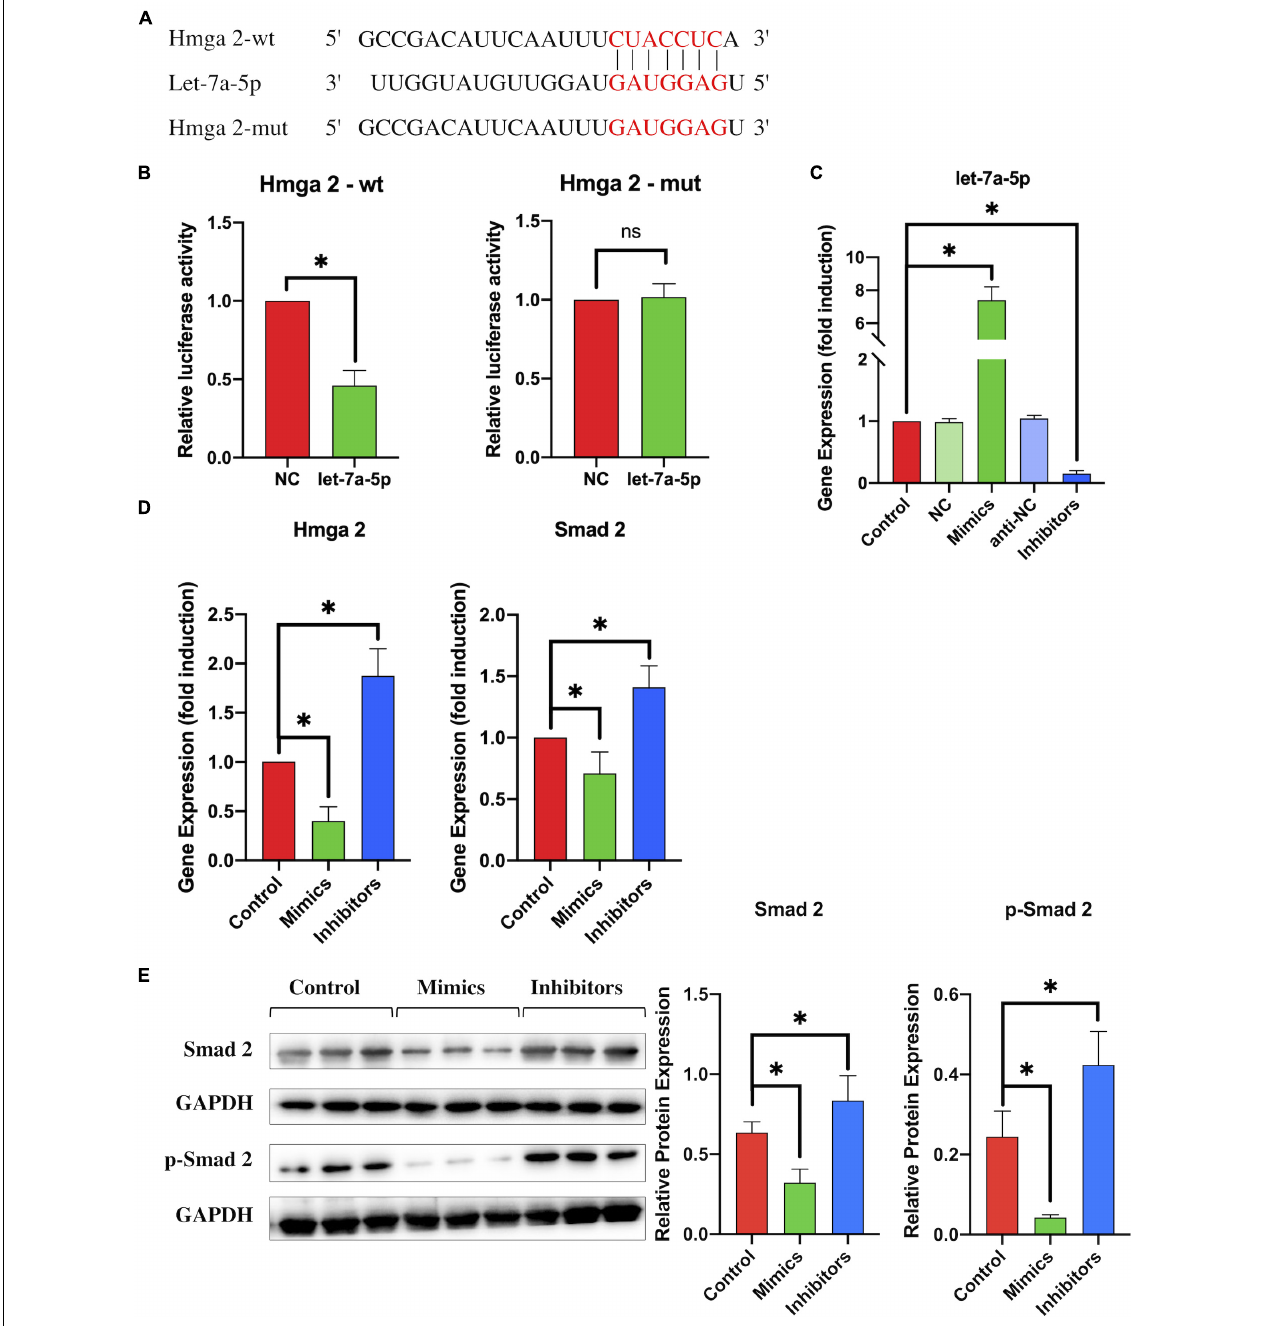
FIGURE 4 | By targeting HMGA2, let-7a-5p downregulated the expression of SMAD2. (A) The target sequence for let-7a-5p in the 3 (cid:48) -UTR of HMGA2 and the mutated target sequence. (B) HMGA2-wt or HMGA2-mut was transfected into NSCs together with let-7a-5p mimics or NC mimics. Dual luciferase reporter analysis confirmed the direct recognition of the HMGA2 3 (cid:48) -UTR by let-7f-5p ( n = 3; data are mean ± S.D; Student’s t- test was used for comparisons; ∗ p < 0.05, n.s. p > 0.05). (C) NSCs were transfected with NC mimics, let-7a-5p mimics, anti-NCs, or let-7a-5p inhibitors respectively; RT-PCR analysis was used to detect the expression of let-7a-5p in NSCs. The analysis showed that transfection of let-7a-5p mimics was able to increase the expression of let-7a-5p. In contrast, the expression of let-7a-5p was reduced by the transfection of let-7a-5p inhibitors after 3 days of NSC culturing ( n = 3). (D) RT-PCR detected the expression of HMGA2 and SMAD2 in NSCs with the addition of let-7a-5p mimics or inhibitors ( n = 3). (E) Western-blot analysis showed that the SMAD2 and p-SMAD2 expression was repressed by the transfection of let-7a-5p mimics. In contrast, the transfection of let-7a-5p increased SMAD2 and p-SMAD2 expression after 3 days of NSC culture ( n = 3; data are mean ± S.D; Student’s t- test was used for comparisons., gene expressions were normalized to the GAPDH (for mRNA) and U6 snRNA (for miRNA), ∗ p < 0.05, ns p > 0.05. The term let-7a-5p mimics is abbreviated as mimics and let-7a-5p inhibitors is abbreviated as inhibitors).